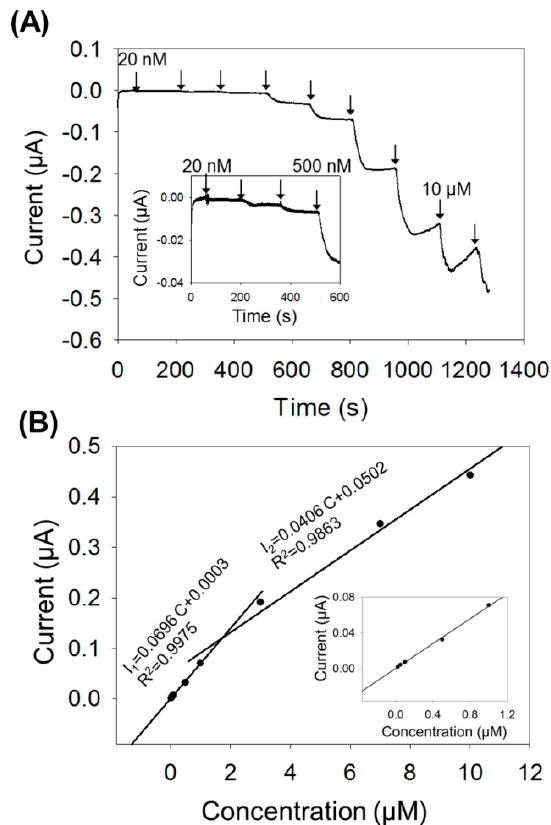
Figure 5. ( A ) Time–current responses of BCNPs/Tyr/Nafion/GCE biosensor for detecting various